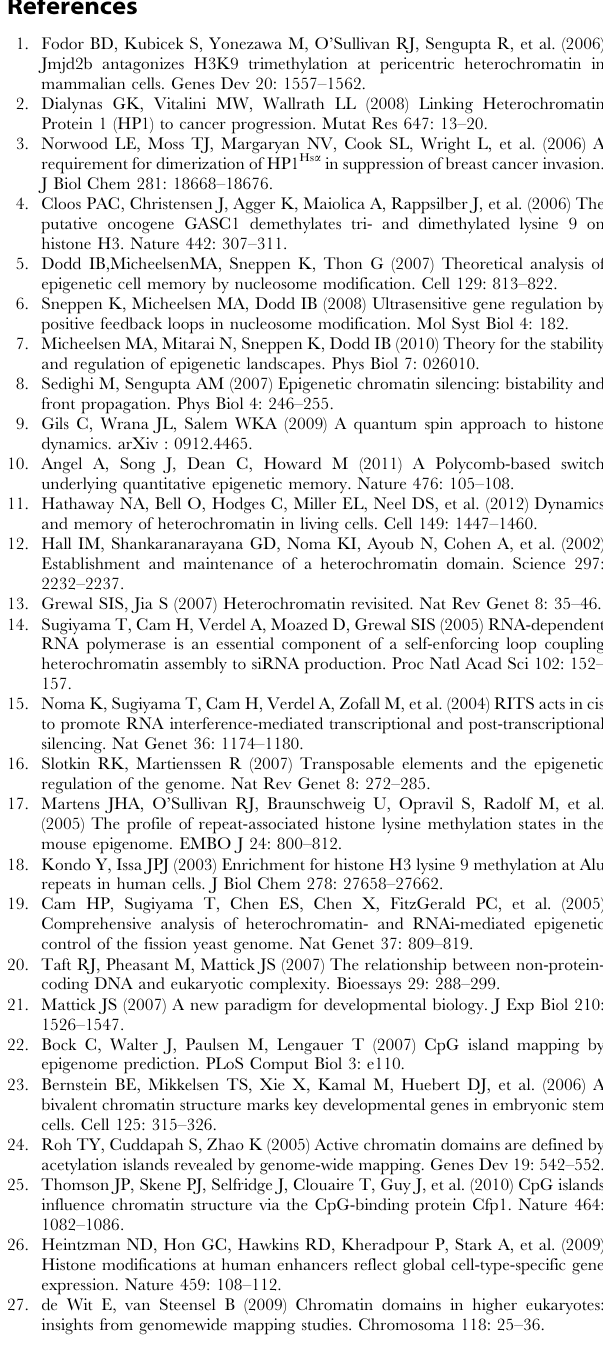
Figure S15. General model behavior. Comparing the average frequency of modifications versus the dissociation rate p s ,1 for different dissociation rates p d . The other parameters